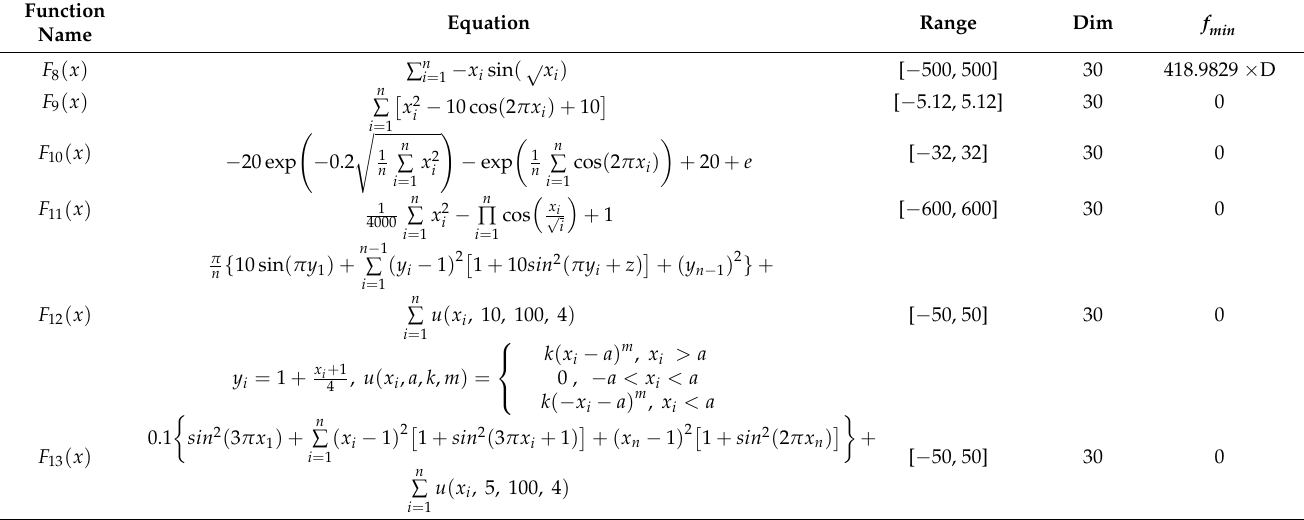
Table 3. Multimodal benchmark function equations.